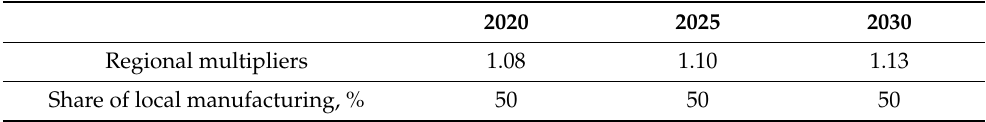
Table 1. Regional multipliers for Ukraine [30].